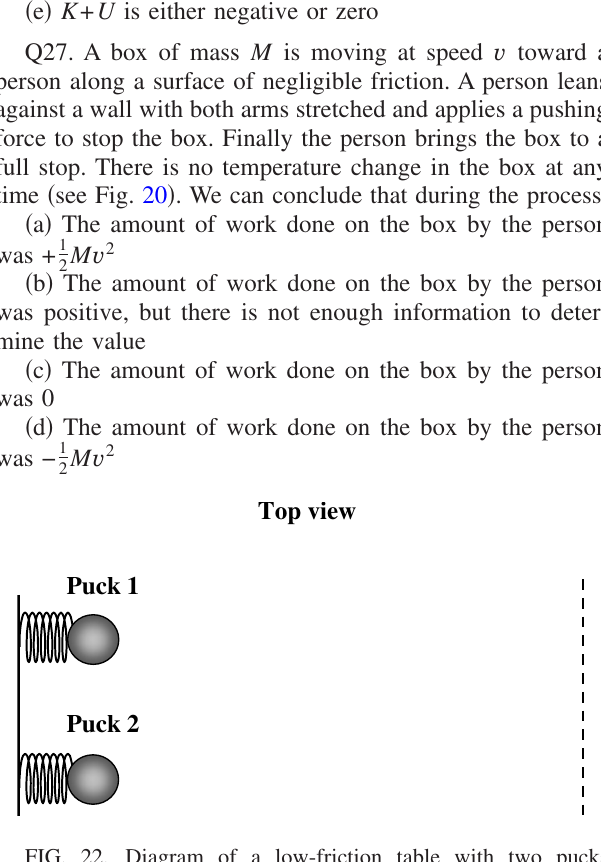
FIG. 20. Diagram of a box of mass M moving at speed v toward a person along a surface of negligible friction.